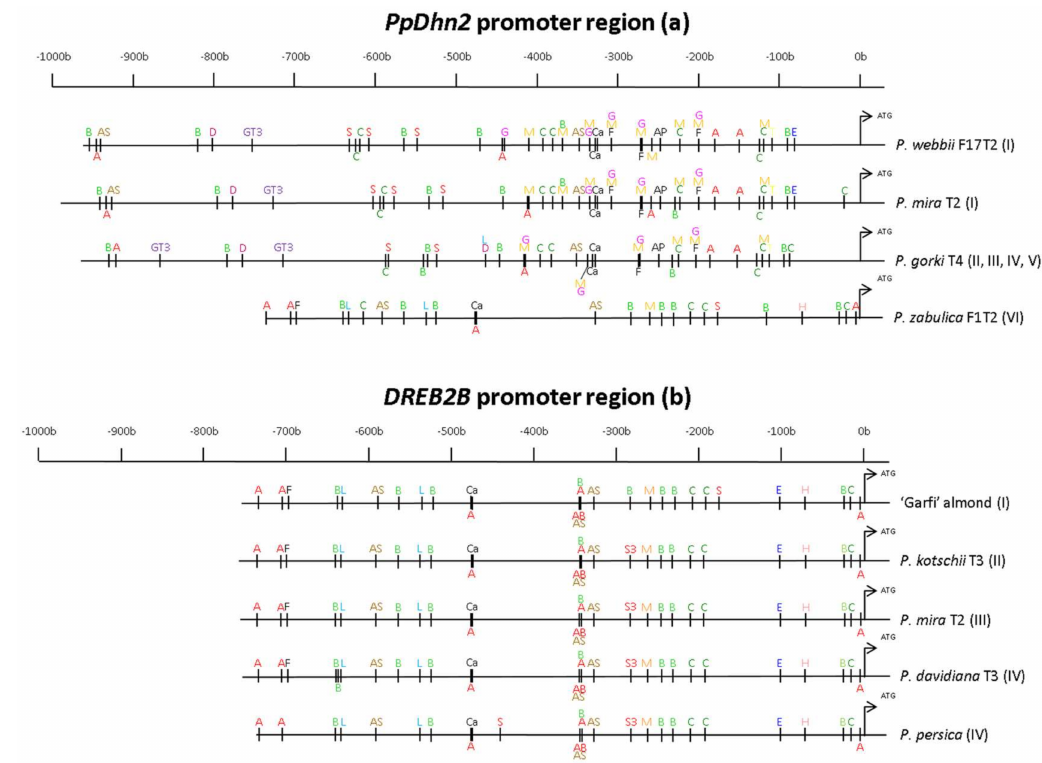
Figure 4. Schematic representation of the 1000 pb region upstream of the PpDhn2 ( a ) and DREB2B ( b ) promoters in each of the cluster-representing individuals. Promoter regions were defined as the first 1000 pb 5 (cid:48) of the translation start site. A: Abscisic acid responsive (ABRE)-elements, in red; AB: ABARE-element, in red; AP: APETALA 2/ethylene-responsive element binding factor (AP2/ERF), in black; AS: ASF-1 binding site, in brown; B: myeloblastosis (MYB)-elements, in light green; C: CAAT-box, in dark green; Ca: Calmodulin-binding motif, in black; D: dehydration-responsive (DRE)-elements, in pink; E: ethylene-responsive element (ERE), in dark blue; F: basic leucine zipper (bZIP) TF, in black; G: G-box, in pink; H: heat shock promoter element (HSE), in salmon; L: low-temperature-responsive element (LTRE), in blue; M: myelocytomatosis (MYC)-elements, in orange; S: SEF4 TF, in red; S3: SEF3 TF, in red; T: TATA-box, in yellow; GT3: GT3-box, in